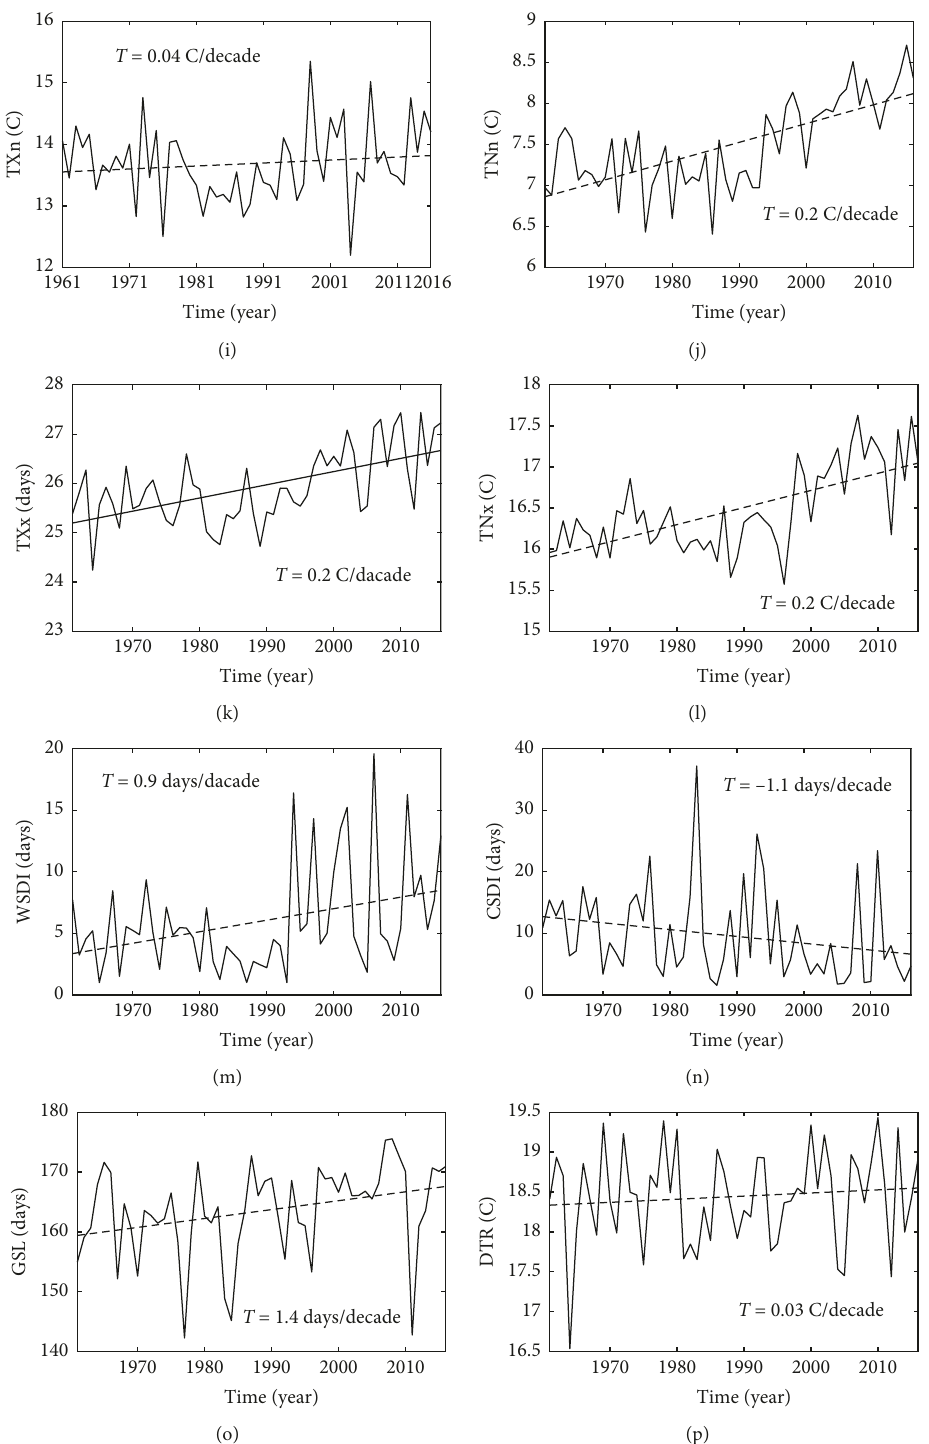
Figure 4: Interannual variation in the extreme temperature index in the Minjiang River Basin from 1961 to